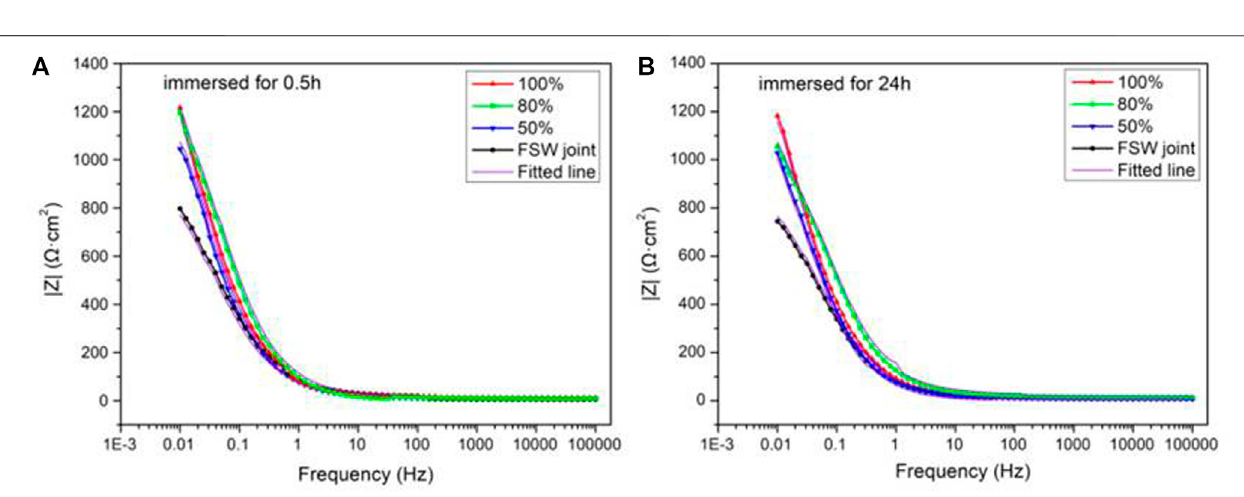
Frontiers in Materials |